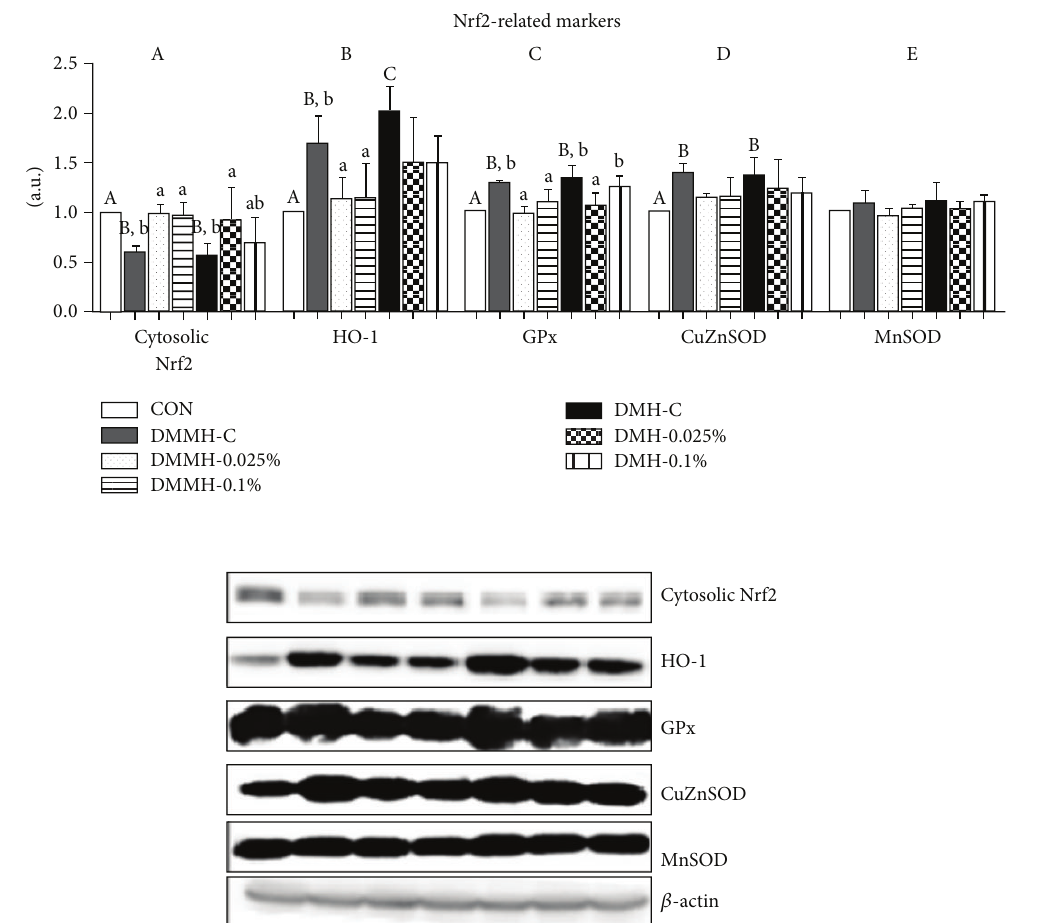
Figure3:EffectofgenisteinsupplementationonthekidneyproteinlevelsofcytosolicNrf2(a),HO-1(b),GPx(c),CuZnSOD(d),andMnSOD (e) in experimental mice. All results were conducted at least three times. Data are presented as means ± SD ( 𝑛 = 9 -10/group). Mean values with different letters were significantly different, 𝑃 < 0.05 . Statistical differences of variables among CON, DMMH-C, and DMH-C analyzed by one-way ANOVA were shown in capital letters and effects of the genistein supplemented diet and/or DM severity using two-way ANOVA were represented by small